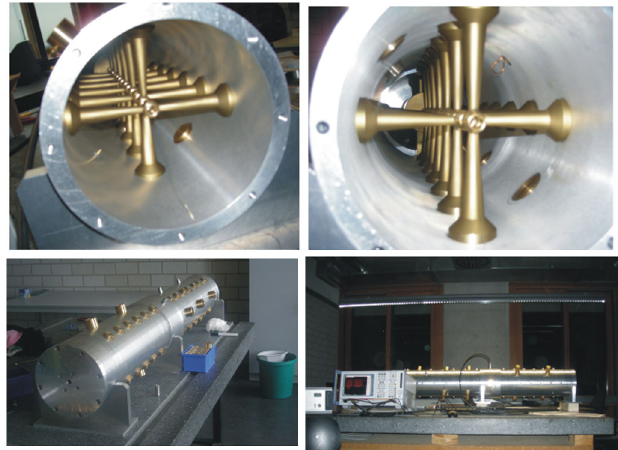
FIG. 40. Photos of the 1:2 model of the second cavity of the FAIR proton